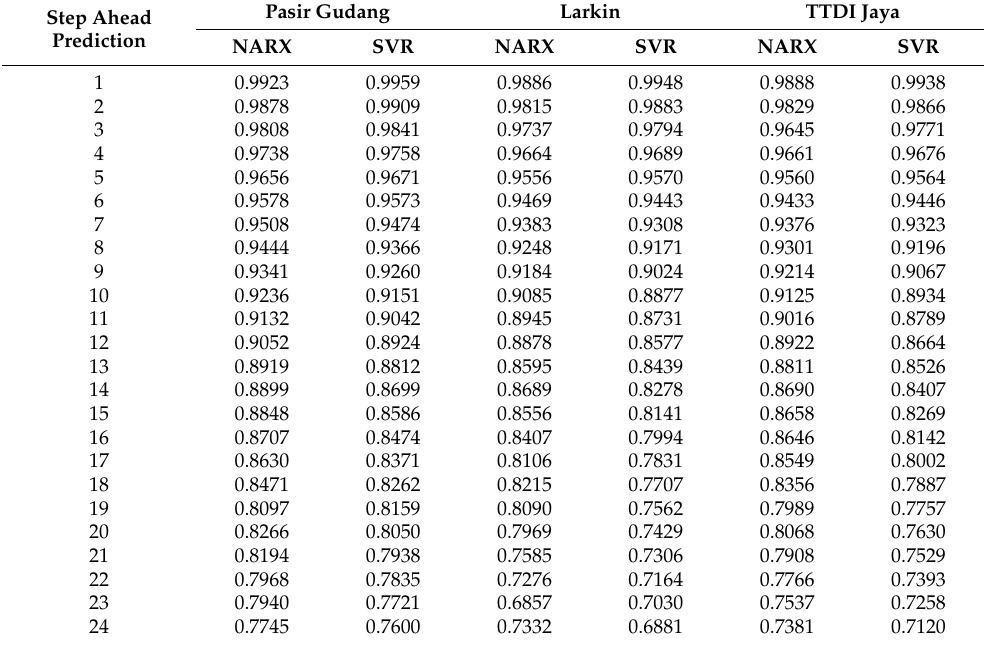
Table 4. NARX and SVR multi-step-ahead prediction performance (in R 2